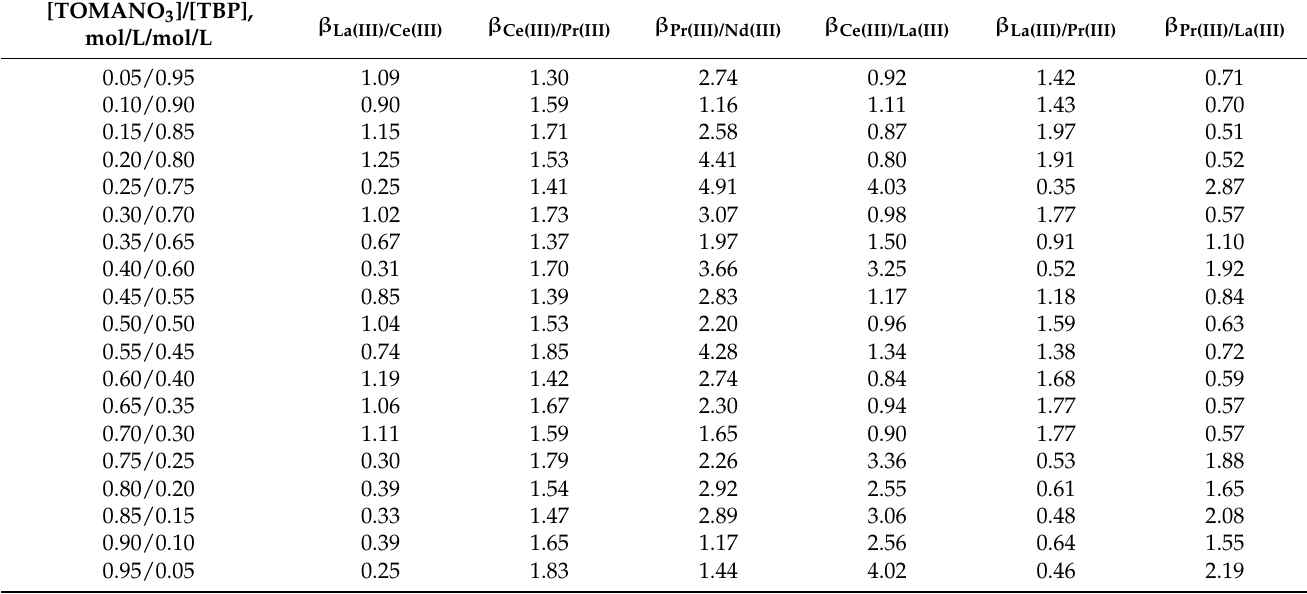
Table 2. Dependence of separation factors for light REEs using 1.0 mol/L isomolar TOMANO 3 -TBP mixtures in